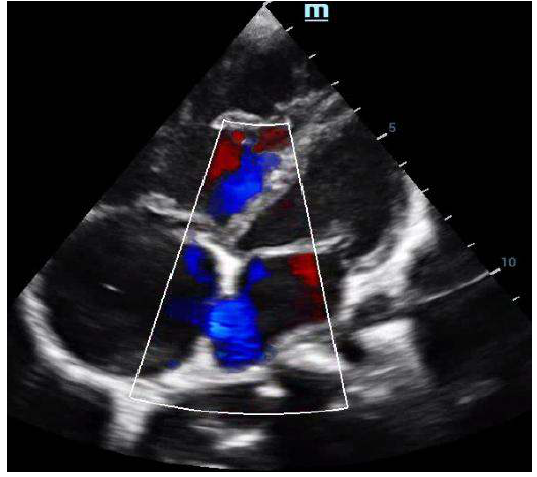
Figure 1: Transthoracic echocardiography showing diversion of IVC flow to left atrium.